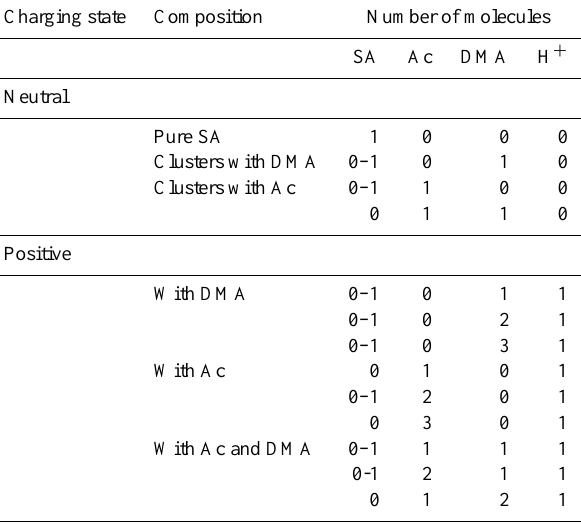
Table 1. Cluster size limits for clusters. If the clusters grow to larger sizes, they will be brought within the system boundaries by evapo- rating